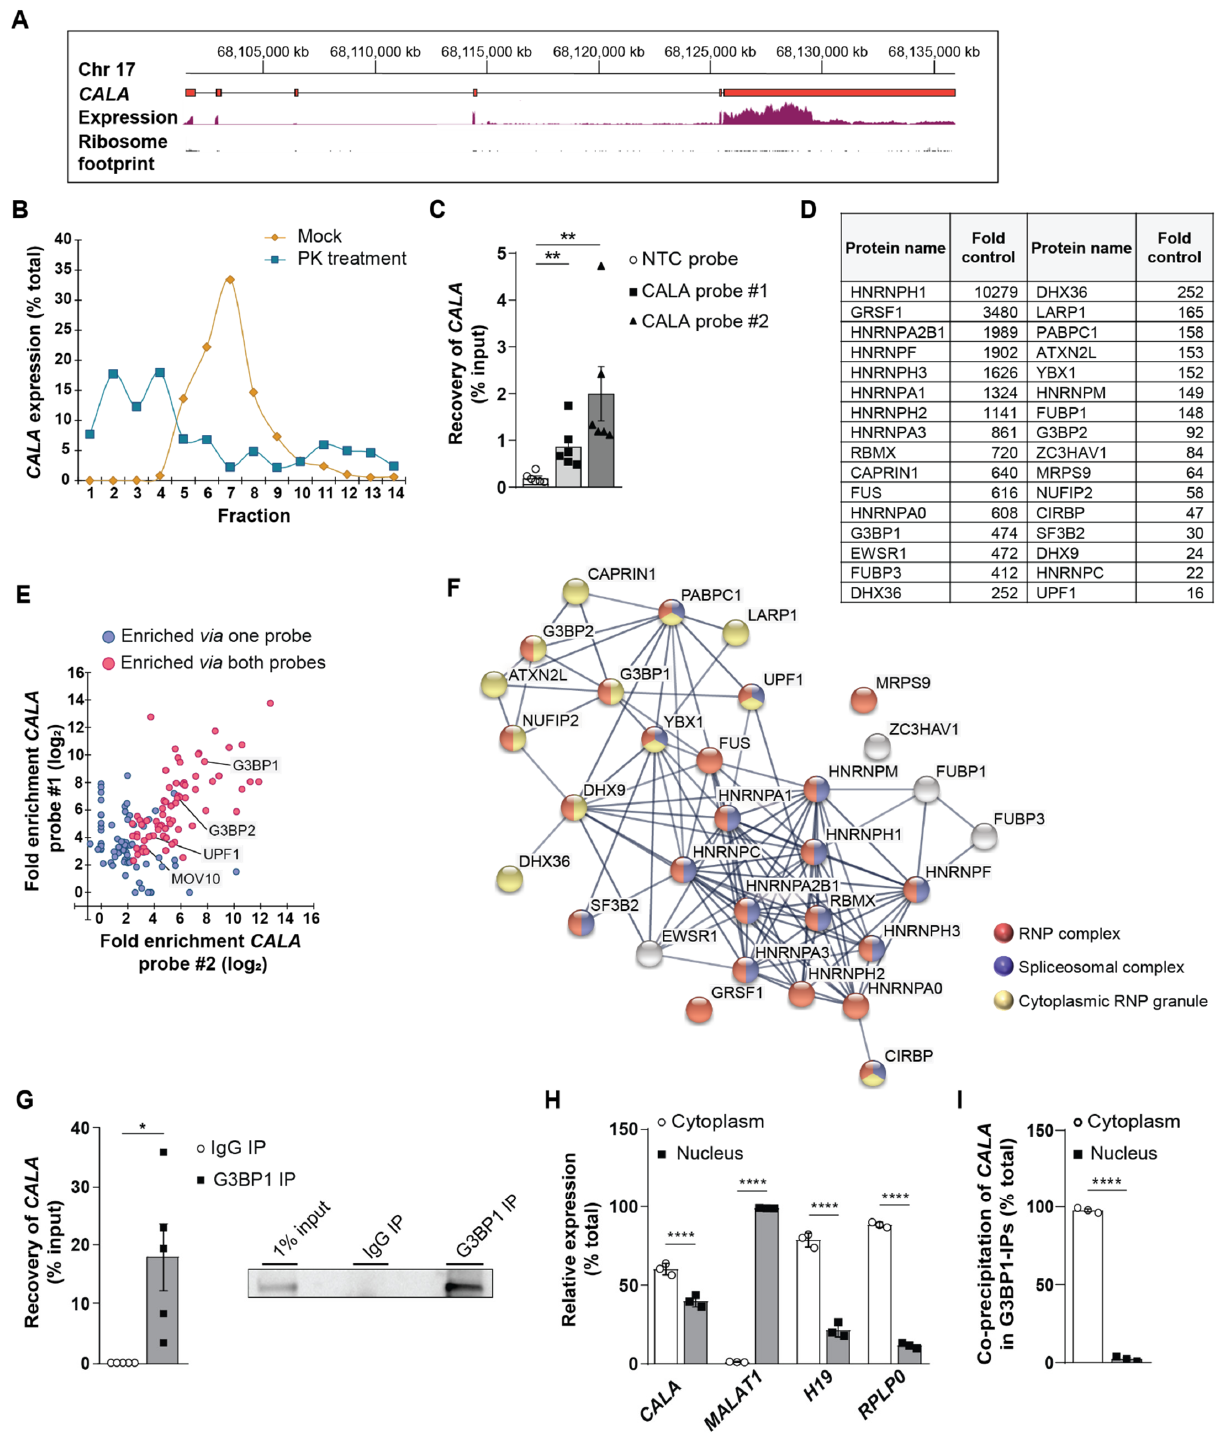
Figure 2. CALA interacts with multiple RNPs and primarily associates with cytoplasmic G3BP1. ( A ) CALA gene locus showing ribosome footprinting (GWIPs-viz-riboseq tracks) and aortic expression data (GTEx V8 RNA-seq). ( B ) Separation and detection of CALA -complexes by sucrose density gradient ultracentrifugation and RT-qPCR, comparing mock and proteinase K-treated whole HUVEC cell lysates (n = 1). Fractions 1 and 14 are top and bottom of the gradient, respectively. ( C )